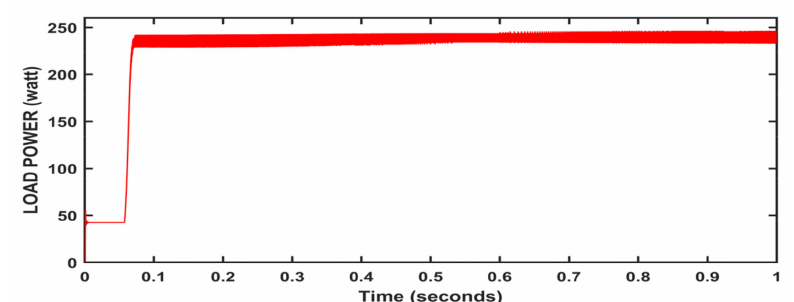
Figure 34. Performances at constant irradiance, temperature, and load.